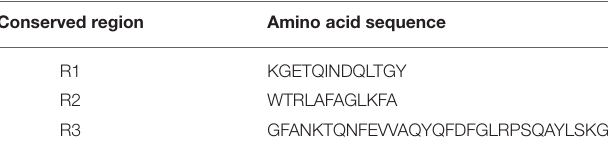
FIGURE 2 | Assessment of Salmonella OmpC clade conservation. (A) Intra-clade conservation of OmpC porin within typhoidal and non-typhoidal Salmonella serovars. Conservation of each Salmonella clade of the OmpC protein identified using a 15 amino acid sliding window approach (in-house software; for a detailed description see methods). The measure of OmpC amino acid conservation within Salmonella clades is shown in Y-axis (0–1), while X-axis shows the position in the aligned amino acid consensus sequence. A conservation value below the first quartile was classed as conserved for each clade. (B) Inter-clade conservation patterns in the protein sequence of OmpC porin among typhoidal and non-typhoidal Salmonella serovars. Full-length OmpC protein sequences were retrieved from NCBI and aligned using Clustal Omega, and inter-serovar conservation was assessed using in-house developed software. The measure of OmpC amino acid conservation between Salmonella clades is shown in Y-axis, while X-axis shows the position in the aligned amino acid consensus sequence. Colors indicate the number of clades that share conservation between each other. Arrows indicate the regions conserved among all Salmonella clades and gray bars indicate regions of distinct cross-clade conservation (see Table 1 ). TABLE 3 | Conserved regions in the amino acid consensus sequences for the porin OmpC among the Salmonella serovars